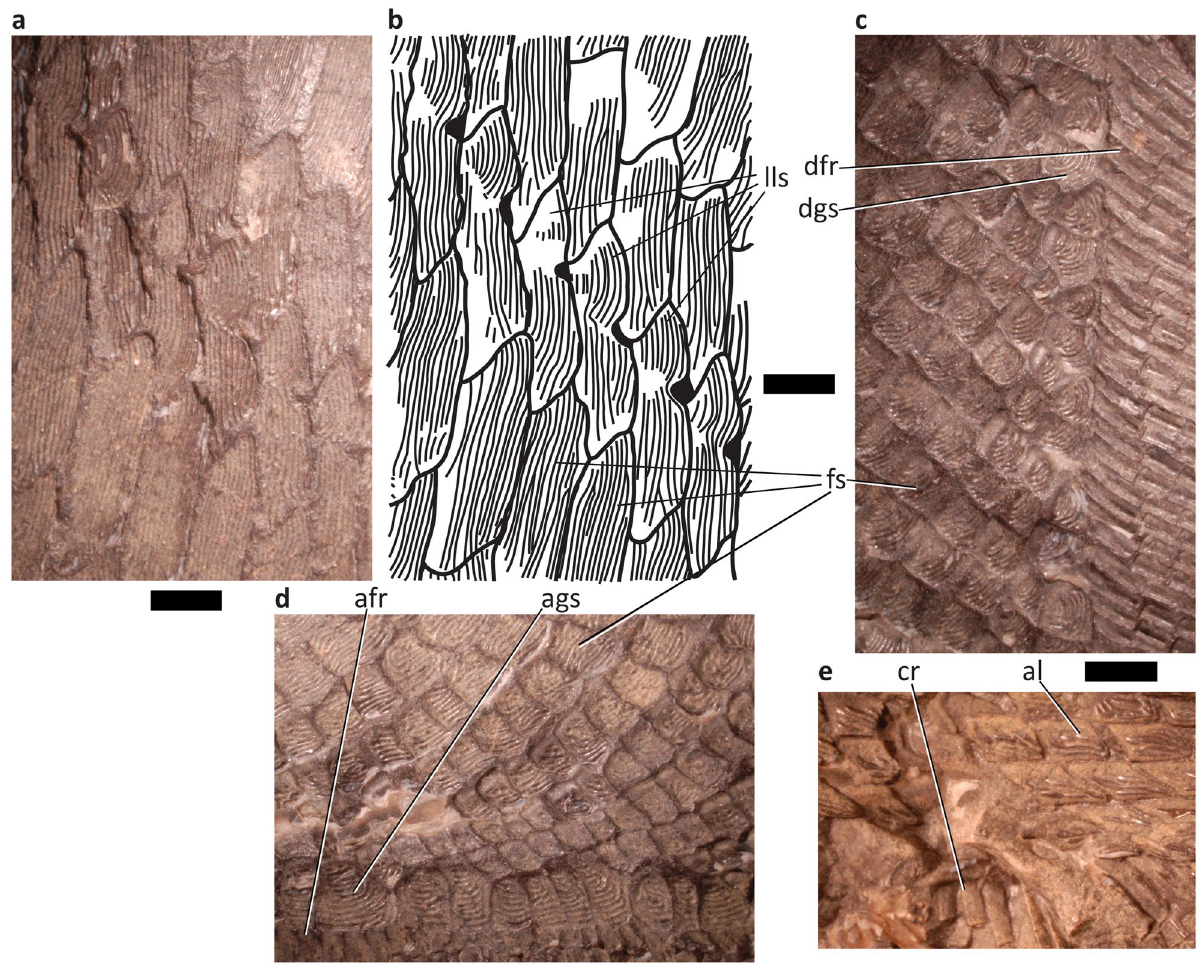
Figure 4. Detail of scale and proximal lepidotrichia of platysomid specimen NSM 017.GF.017.001. Scale bars = 2 mm. ( a ) Detail of flank and lateral line scales. ( b ) Line illustration of flank and lateral line scales. ( c ) Detail of scales and lepidotrichia proximal to dorsal fin. ( d ) Detail of scales and lepidotrichia proximal to anal fin. ( e ) Detail of scales and lepidotrichia in caudal fin. al, axial lobe; afr, anal fin rays; ags, anal guard scales; cr, caudal lobe rays; dfr, dorsal fin rays; dgs, dorsal guard scales; fs, flank scales; lls, lateral line